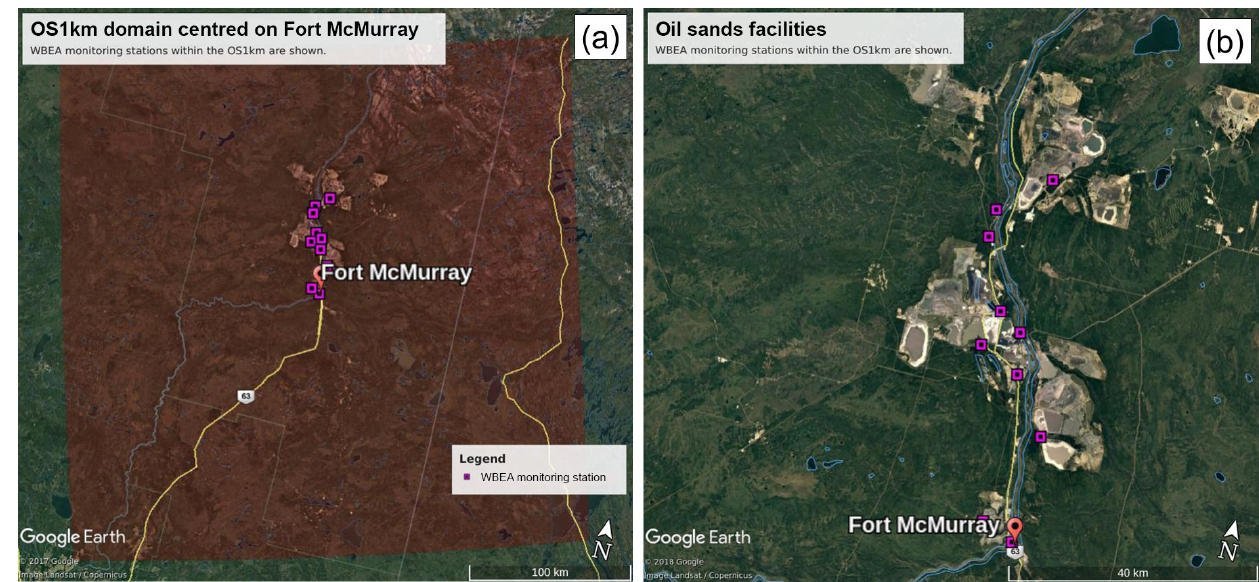
Figure 7. Illustration of the OS1km domain, with observation station locations. (a) Entire domain. (b) Close-up view of station locations. Monitoring stations are shown as purple outline squares in both images. Light grey regions in the background satellite image (b) are oil sands open-pit mining